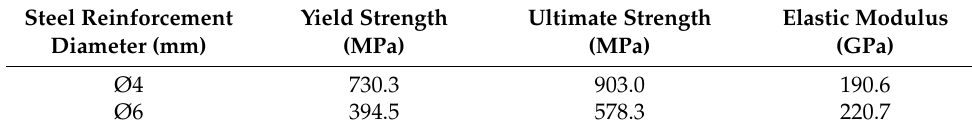
Table 2. Mechanical properties of steel bars